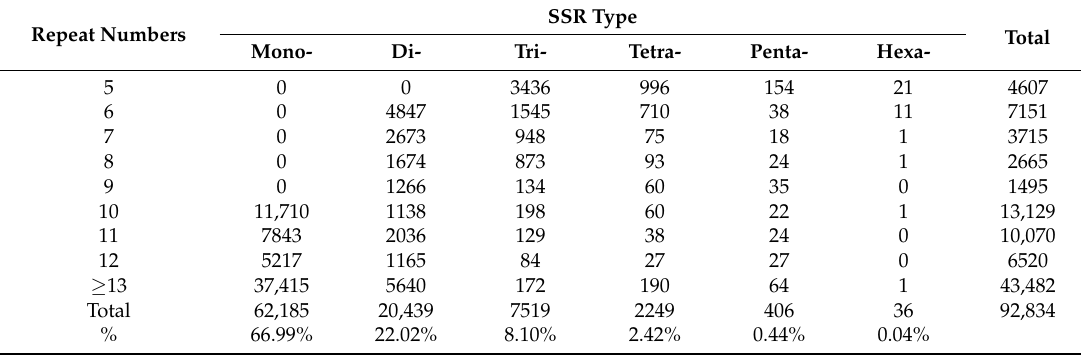
Table 4. Distribution of simple sequence repeat (SSR)s based on the number of repeat